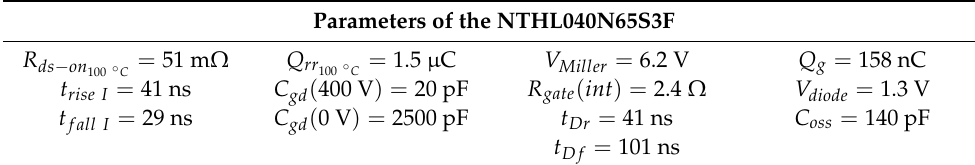
Table 5. Parameters of the NTHL040N65S3F. Parameters of the